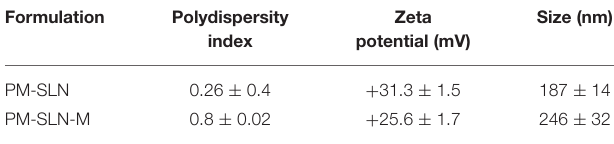
TABLE 1 | Specific properties of synthesized nanoparticles.